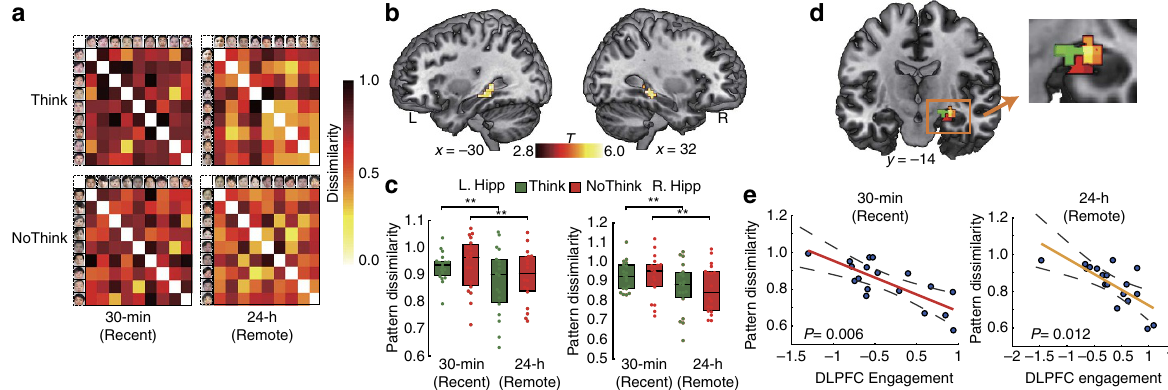
Figure 5 | Decreased hippocampal pattern dissimilarity following consolidation. ( a ) 9 (cid:3) 9 correlation matrix representing item-by-item pattern dissimilarity in the hippocampus for four separate experimental conditions. Each box corresponds to the specific item cue which is shown for visualization purposes. ( b ) Increased pattern dissimilarity in the bilateral hippocampus (MNI, left: peak at (cid:2) 33, (cid:2) 27 and (cid:2) 12; right: peak at 33, (cid:2) 36 and 0) for suppression of newly acquired compared with consolidated aversive memories, which is derived from inter-item multivoxel pattern dissimilarity analysis on the whole-brain level using a searchlight method. ( c ) Box plots reveal median (black line) multivoxel pattern dissimilarity in the bilateral hippocampus. Dots represent pattern dissimilarity for each participant. Error bars represent s.e.m. ( d , e ) Pattern dissimilarity in the anterior hippocampus was negatively predictive of DLPFC engagement in suppression of both newly acquired (cluster in hot) and consolidated (cluster in red) aversive memories. The cluster in green represents the overlapping area. Dashed lines indicate 95% confidence intervals, and solid lines indicate the best linear fit. * P o 0.05; ** P o 0.01; Colour bar represents T values; a.u., arbitrary units; L, left; MNI, Montreal Neurological Institute coordinate system; R, right. ( (cid:2) 33, (cid:2) 27, (cid:2) 12), and (33, (cid:2) 36, 0) in MNI coordinates; pattern dissimilarity was negatively predictive of the right Supplementary Table 5) that showed more generalized multivoxel DLPFC engagement in memory suppression for both newly activation patterns for aversive memories after overnight acquired ( r (predicted, observed) ¼ (cid:2) 0.74, P ¼ 0.006) and overnight ( r (predicted, observed) ¼ (cid:2) 0.67, P ¼ 0.012) memories (Fig. 5d,e). consolidation (Fig. 5b,c). Importantly, the hippocampal NATURE COMMUNICATIONS|7:13375|DOI: